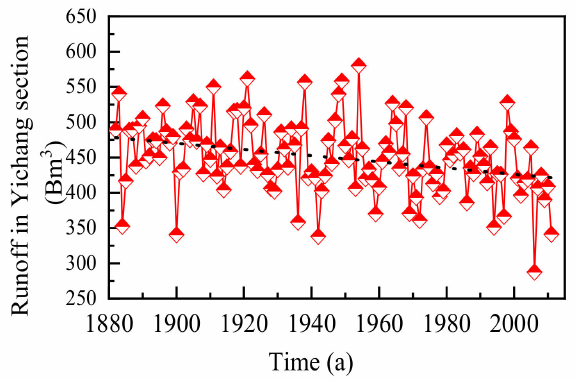
Figure 4. Change in annual runoff in Yichang section.